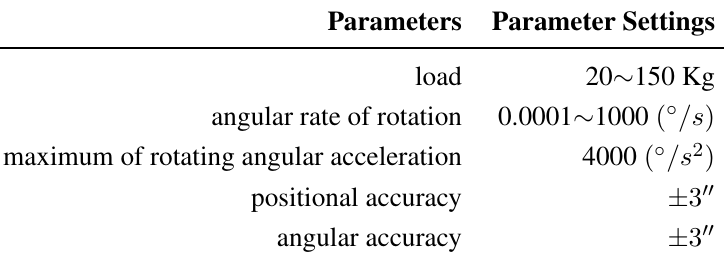
Table 2. Performance parameters of the turntable.